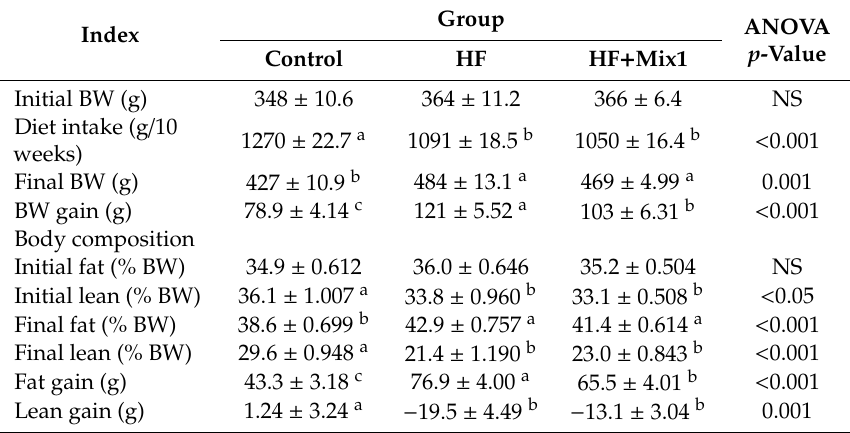
Table 3. E ff ects of mixture 1 on the diet intake, body weight, and body composition of rats fed a high-fat